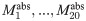
Transfer with multiple state abstractions curriculum.(A) A curriculum of transfer tasks is generated by first constructing the three-state MDP. At each state, only one action causes a transition to a different state. Only one state-to-state transition is rewarded; the optimal policy is to select the correct action needed to cycle between the node states. (B) To generate a sequence of abstract MDPs M1abs,...,M20abs, the action labels are randomly permuted as well as the transitions generating positive reward (similar to the Diabolical Rooms Problem [3]). Two hidden state abstractions ϕA and ϕB were randomly selected to “inflate” each abstract MDP to a nine-state problem. One state abstraction was used with a frequency of 75% and the other with a frequency of 25%. The resulting MDP sequence M1, …, M20 was presented to the agent, without any information about which state abstraction was used to construct the task sequence.